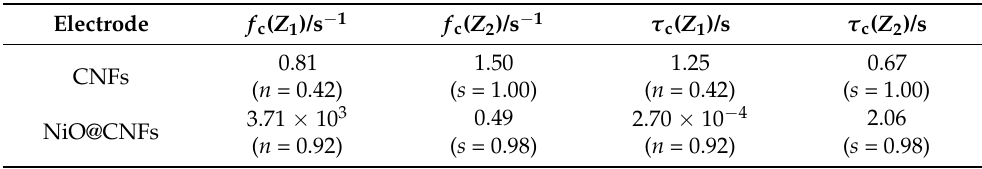
Table 3. Characteristic frequencies and time constants for the ionic ( Z 1 ) and electronic ( Z 2 ) transports according to the theoretical impedance model represented by Equation (1). The exponents n and s are obtained from Equations (3) and (4),